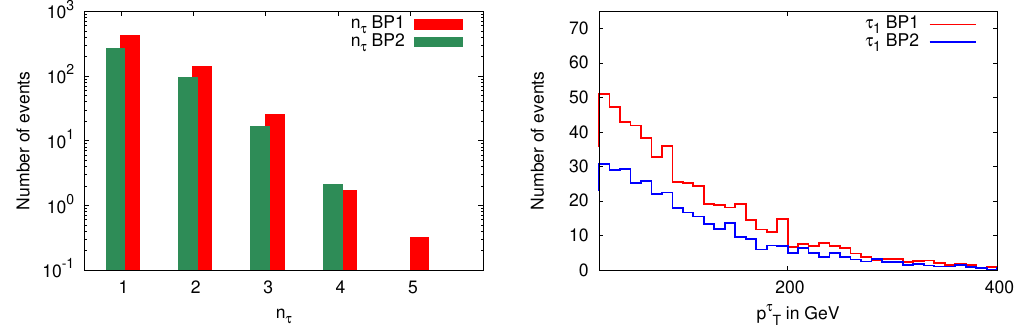
Figure 2 . n (cid:28) distribution (left panel) and p (cid:28) jet integrated luminosity of 100 fb (cid:0) 1 at the LHC with center of mass energy of 14 TeV.